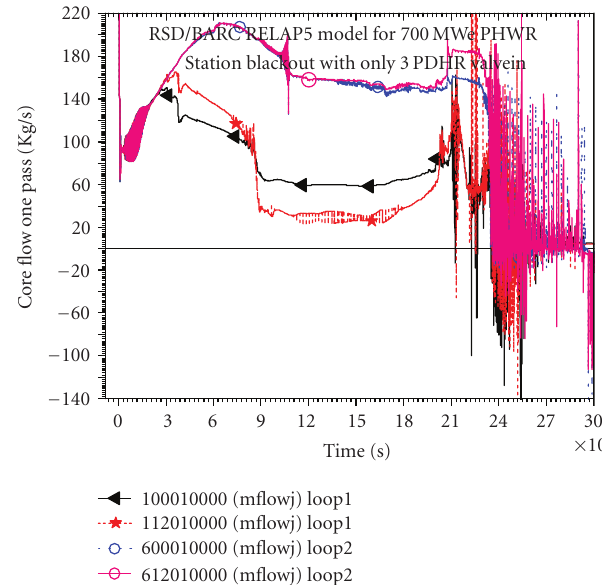
Figure 18: Core flow case-3PDHRs with no loop isolation.